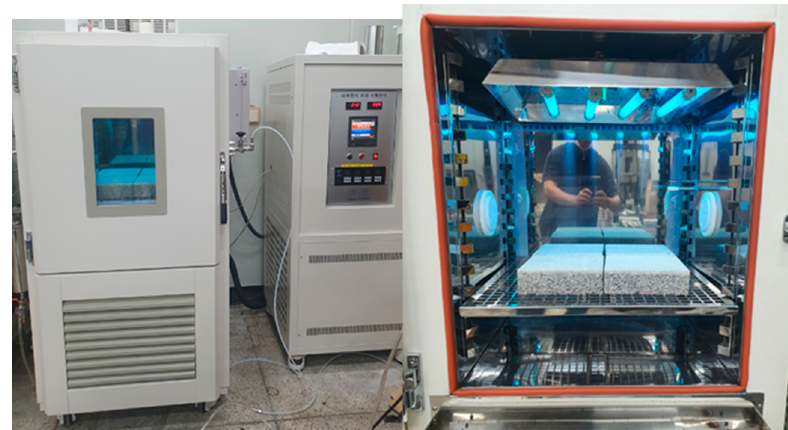
Figure 7. Laboratory experiment with environment chamber.